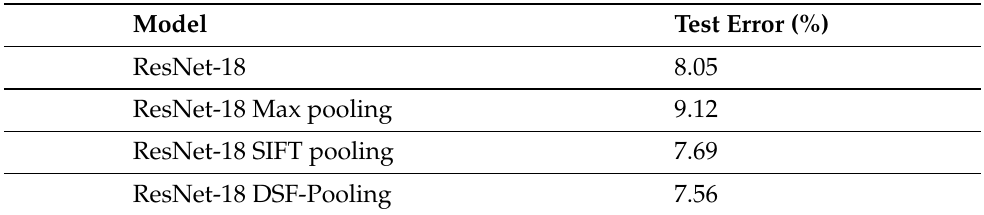
Table 1. Experiments with ResNet-18 on CIFAR-10.